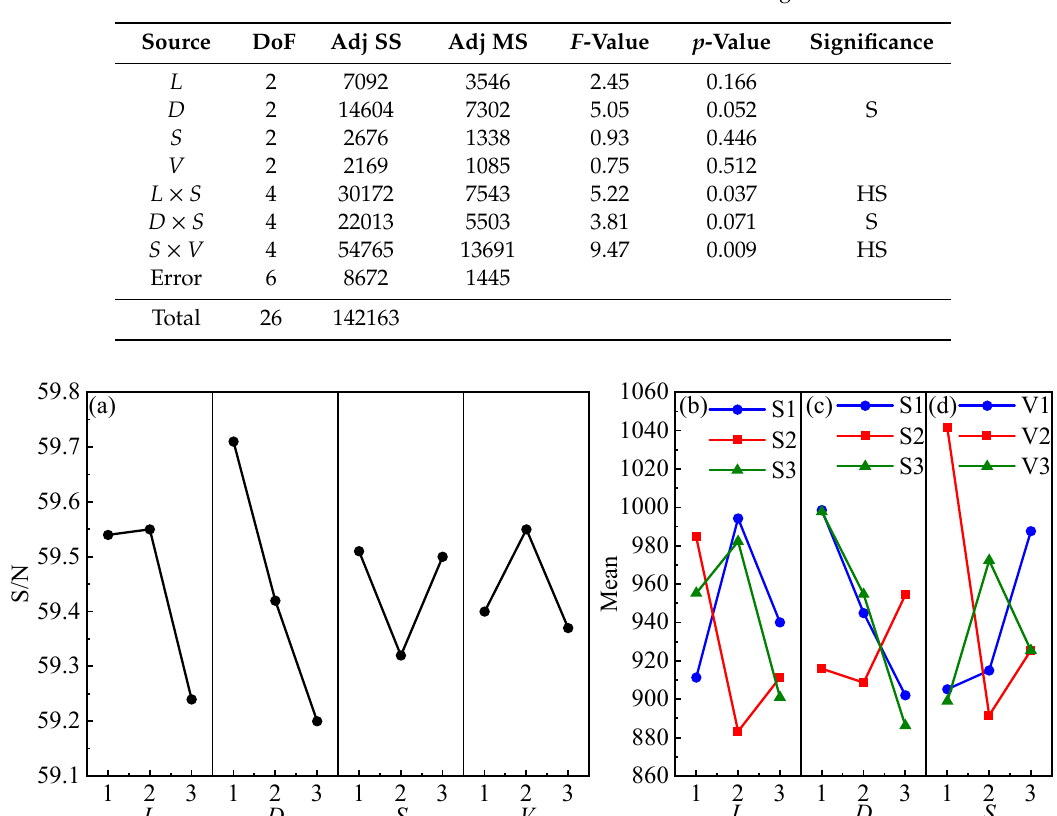
Table 5. ANOVA of the micro-hardness of the coatings.